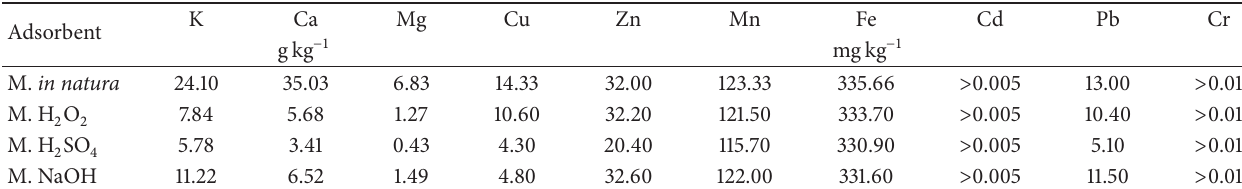
Table 2: Mean concentration of elements of the adsorbents.